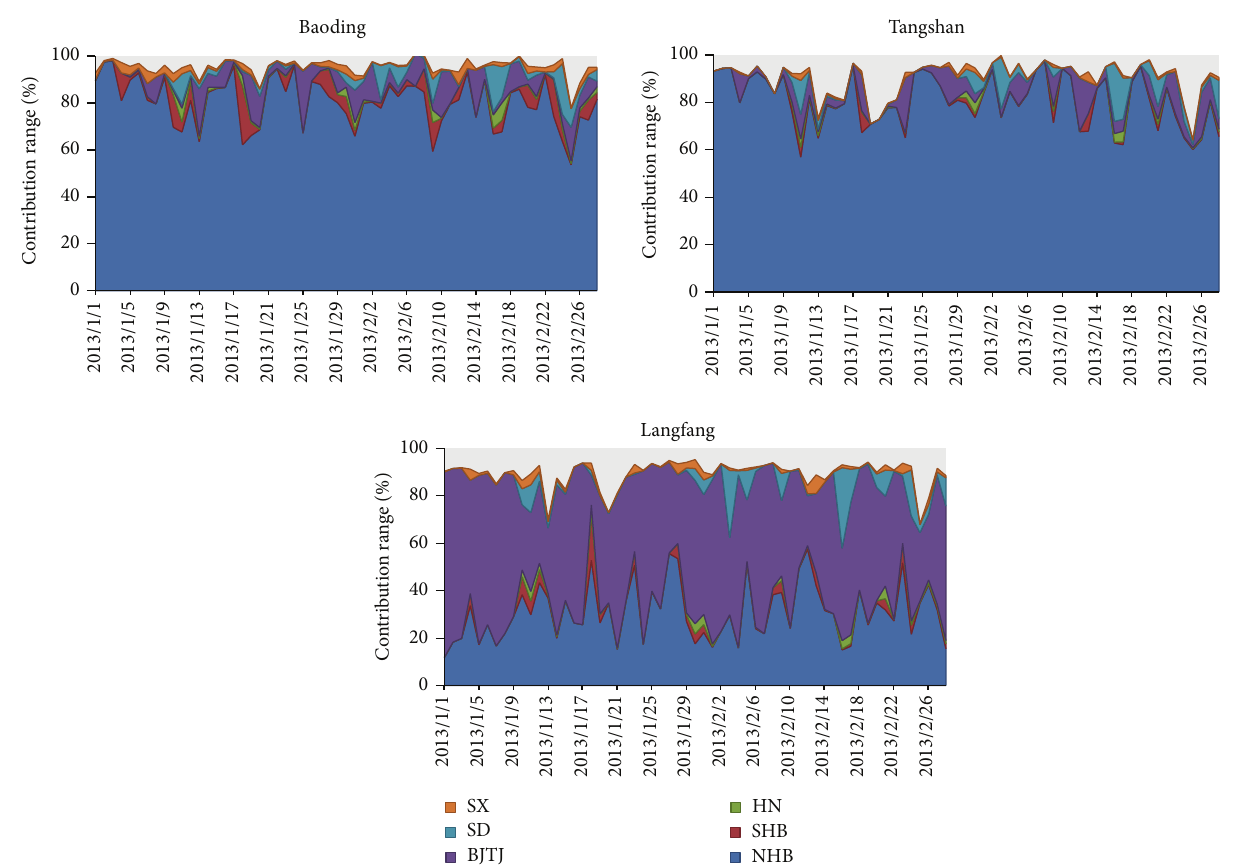
Figure2:ThesourcecontributionsrangesbyspatialsourcetoPM 2.5 concentrationsin11citiesofHebei(SHB:southernHebei;NHB:northern Hebei; BJTJ: Beijing and Tianjin; SX: Shanxi; SD: Shandong; HN: